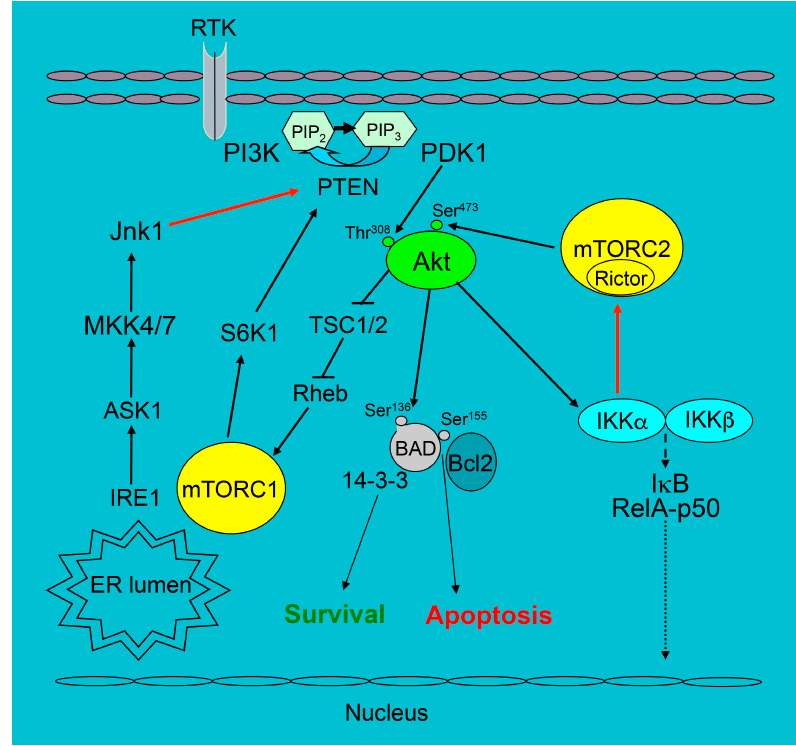
Figure 1. The survival signaling pathways related to the PI3K / Akt pathway in mouse macrophages. The black arrows show the direction of signaling, T-bars indicate the suppression of following signaling and dotted arrows are possible phosphorylation of I κ B with release the complex into nucleus whereas the red arrows are the part of signaling we discussed in our review.